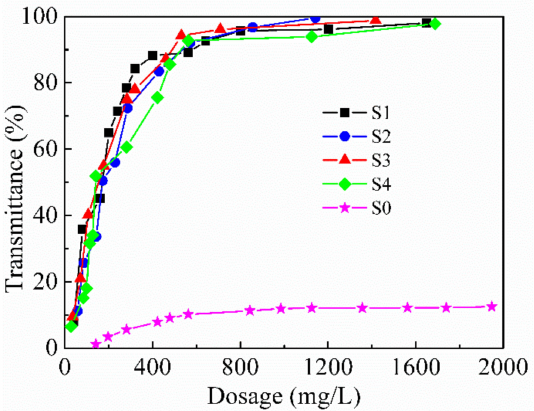
Figure 3. Demulsification e ff ect of various Fe 3 O 4 MNPs in diesel oil-in-water